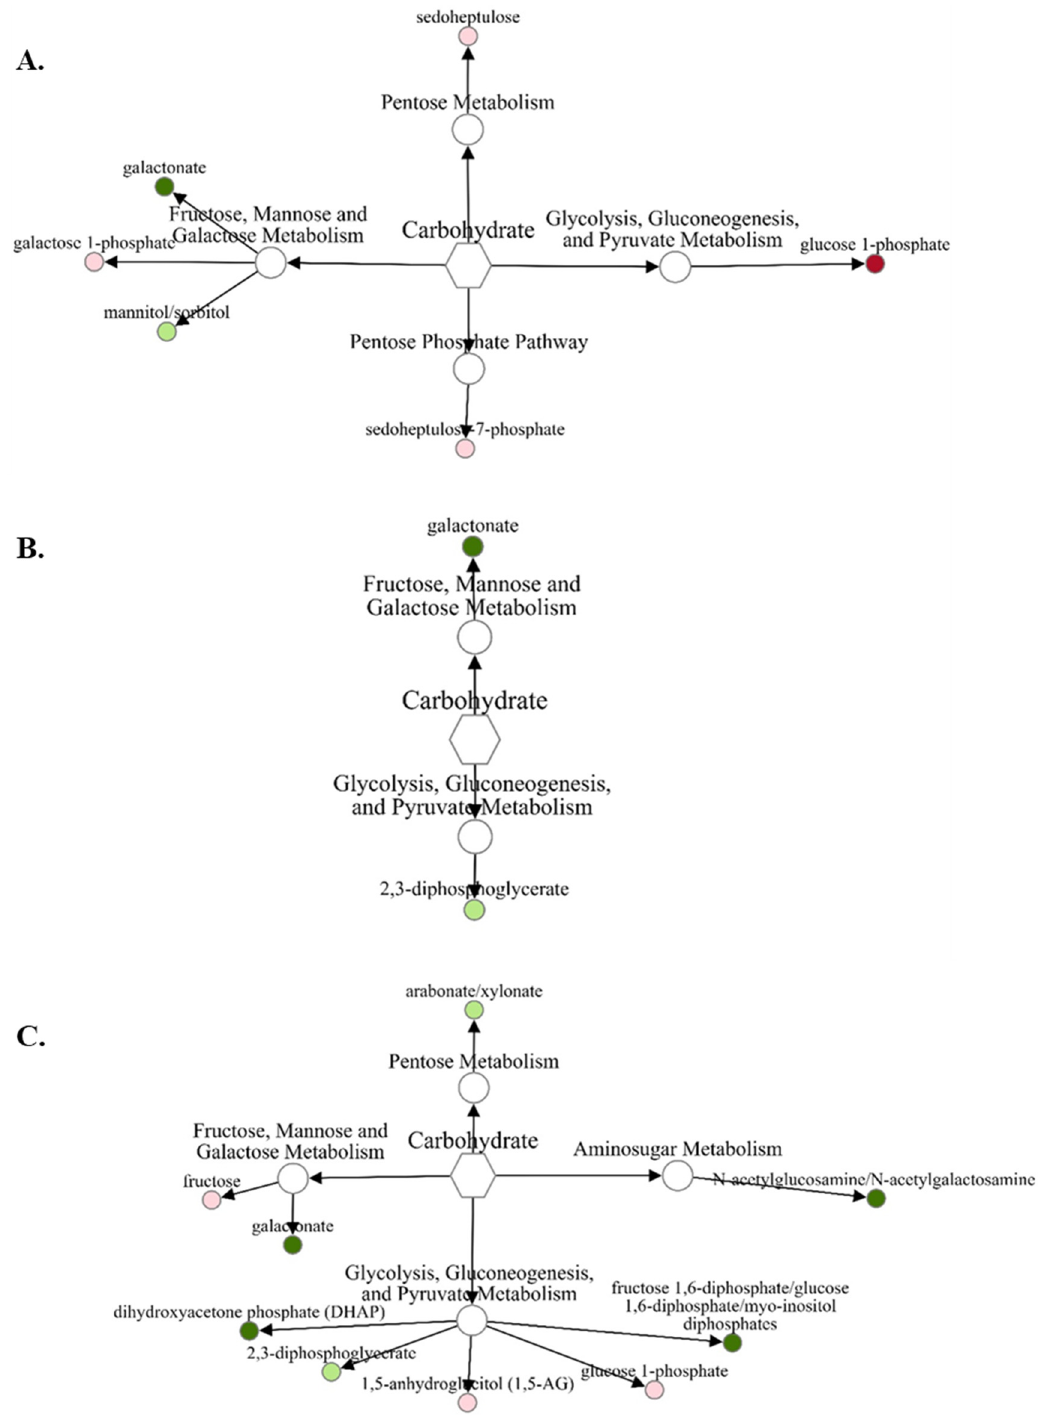
Figure 2. Network comparison of carbohydrate metabolites relative flux in fetal liver of VTM-LG vs. NOVTM-LG ( A ), NOVTM-MG vs. NOVTM-LG ( B ), and VTM-MG vs. NOVTM-LG ( C ). VTM = supplemented with vitamin/mineral. NOVTM = not supplemented with vitamin/mineral. LG = fed to gain 0.28 kg/day. MG = fed to gain 0.79 kg/day. Node diameter is proportional to the fold-change observed. Node color represented the significance of the change: dark red is an increase ( p ≤ 0.05), light red is a tendency to increase (0.05 < p ≤ 0.10), dark green is a decrease ( p ≤ 0.05), and light green is a tendency to decrease (0.05 < p ≤ 0.10). Only significant biochemicals are